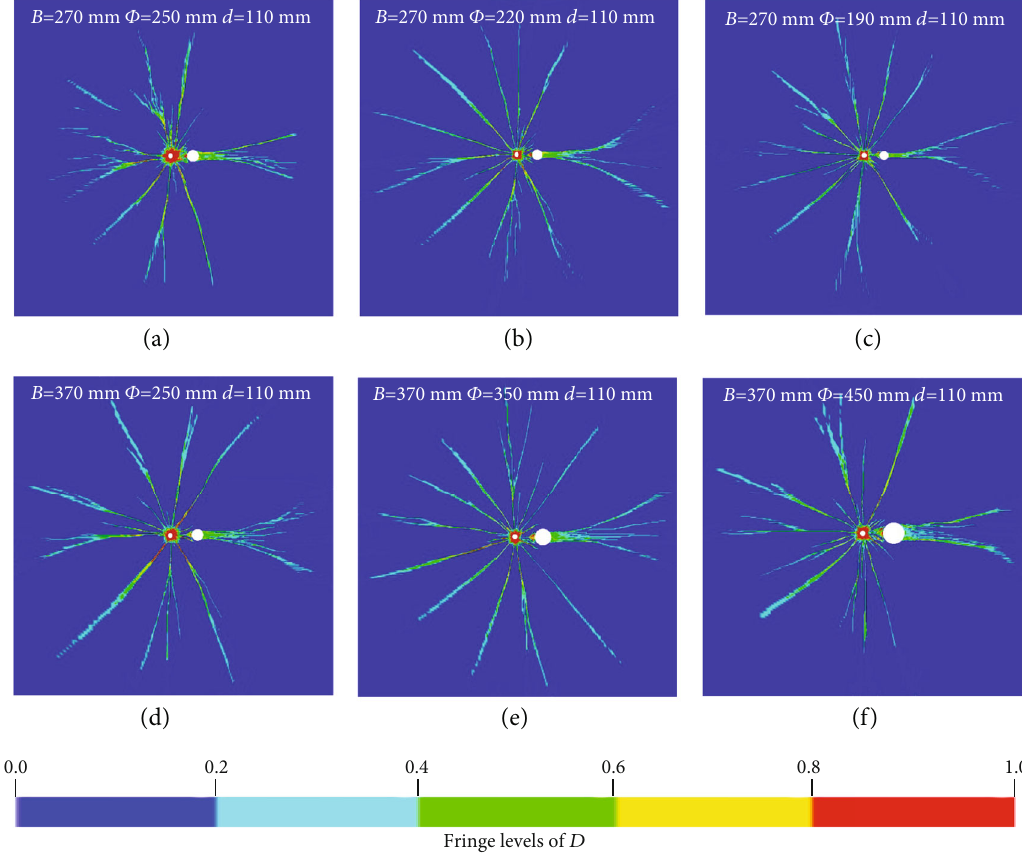
Figure 6: Overall damage of prime cut blasting under di ff erent diameters of the empty hole: (a) scheme 3, (b) scheme 7, (c) scheme 8, (d) scheme 5, (e) scheme 9, and (f) scheme